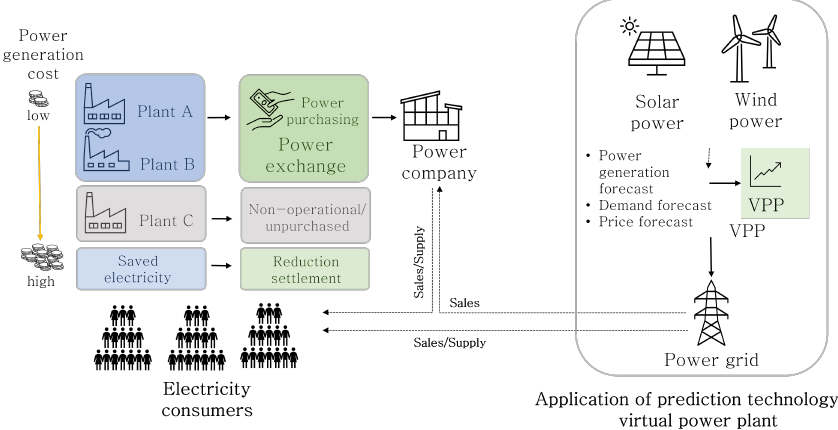
Figure 1. Electricity transaction flow chart in the Korean electricity